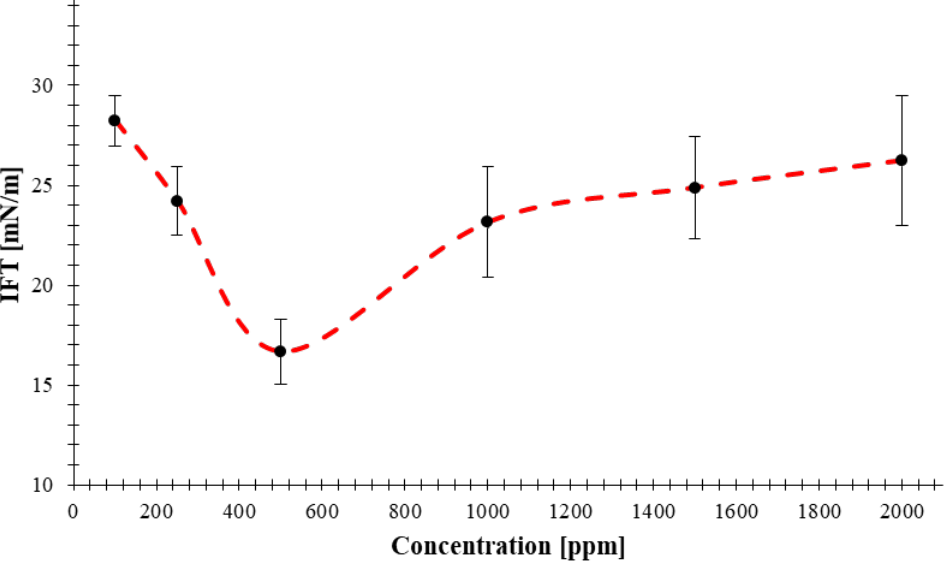
Nanomaterials 2020 , 10 , x 18 of 26 Figure 13. IFT measurement results for the prepared nanofluids. Figure 13. IFT measurement results for the prepared nanofluids.